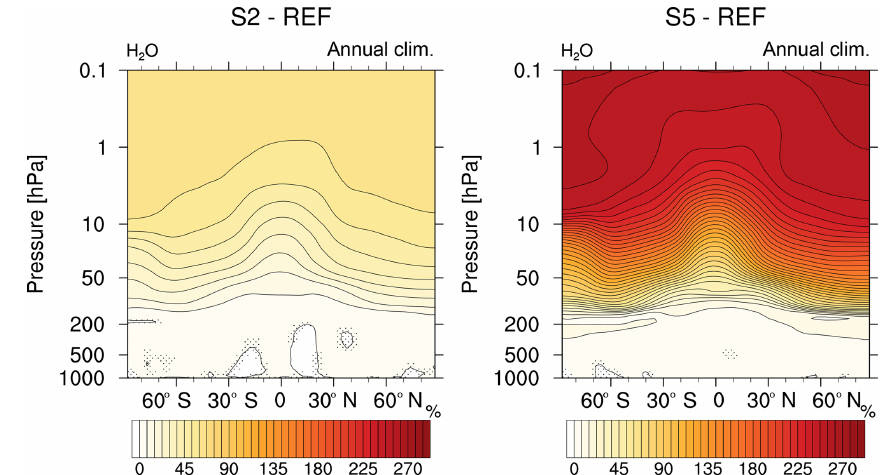
Figure 5. Comparison of the relative changes (%) in annual zonal mean H 2 O mixing ratio of the sensitivity simulations S2 and S5 (2- and 5-fold CH 4 , respectively) compared to the reference REF. Non-stippled areas are significant on a 95% confidence level according to a two-sided Welch’s test.